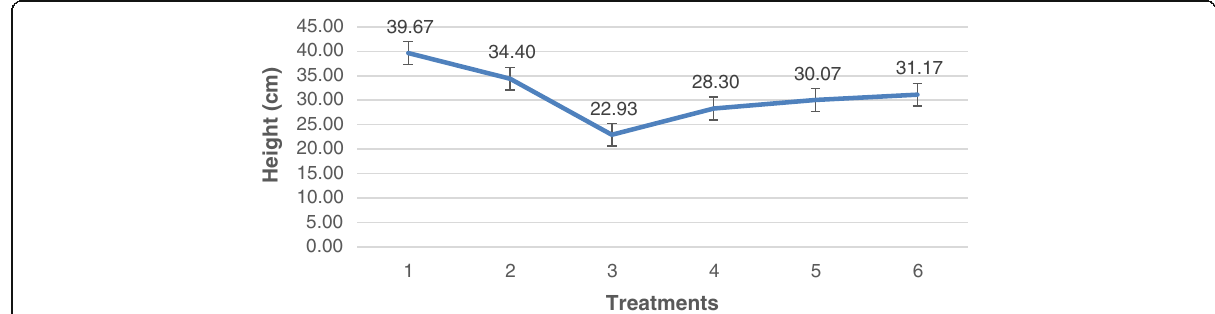
Fig. 4 Effect of soil infection with Trichoderma harzianum , Phythium ultimum , and Phytopthora capsici on tomato plant height (cm) in a pot experiment. 1, uninoculated control (healthy); 2, T. harzianum (alone); 3, inoculated with P. capsici (alone); 4, inoculated with P. ultimum (alone); 5, inoculated of P. capsici with T. harzianum ; 6, P. ultimum with T. harzianum